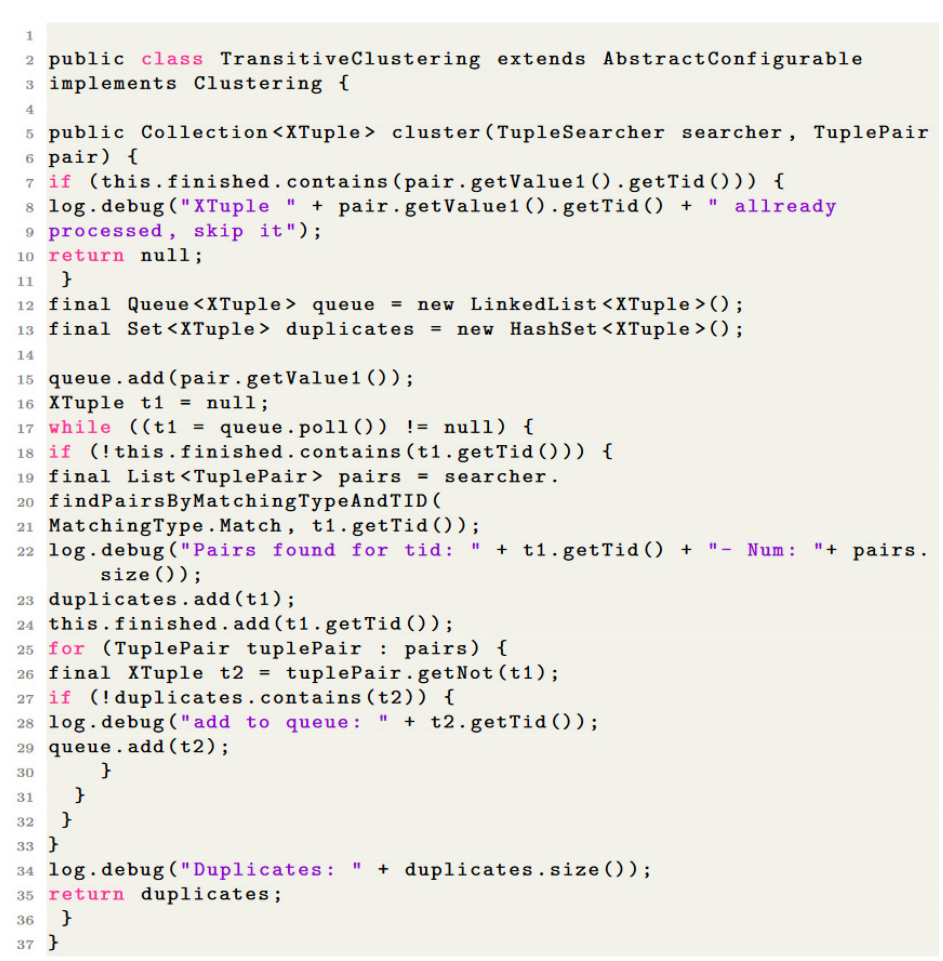
Figure 7. Transitive clustering code.